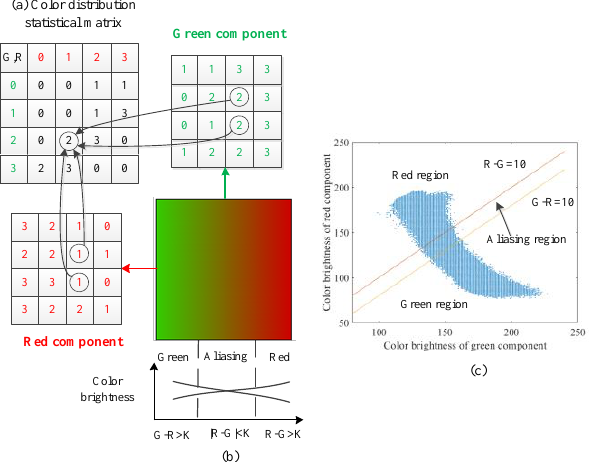
Figure 3. Initial cluster centers based on CDSM.